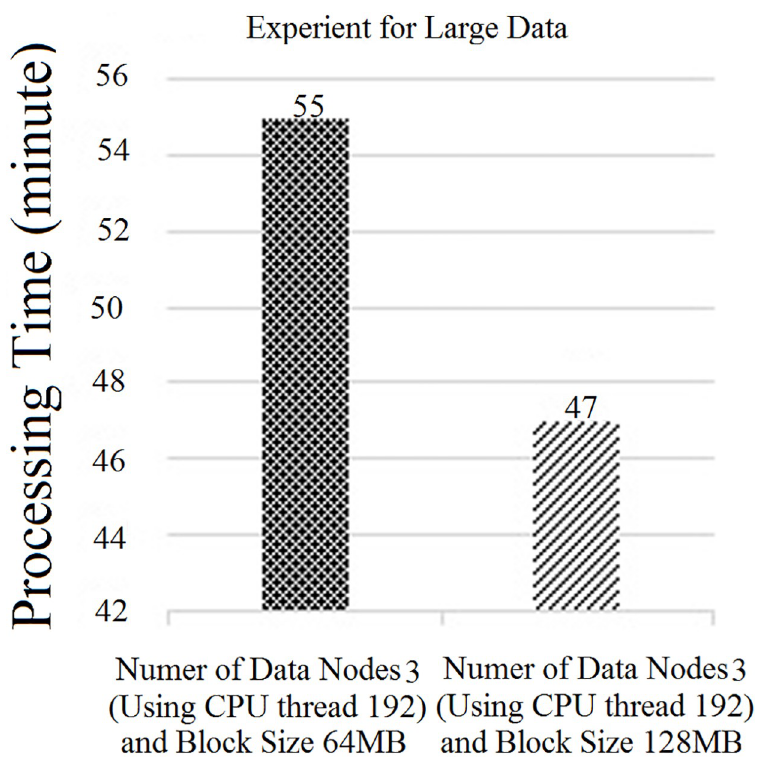
Fig 15. Performance of Hadoop (64 threads each DataNode) on large data with different block sizes.